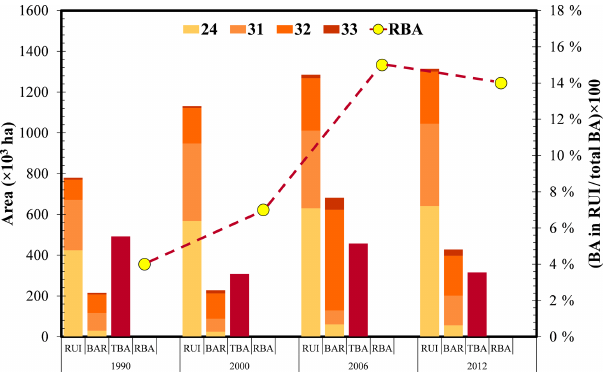
Figure 9. Evolution of the absolute value of the area of the rural– urban interface (RUI), burnt area within the RUI (RBA), total burnt area (TBA), and relative burnt area within the RUI (RBA, as %), for each investigated period (1990, 2000, 2006, and